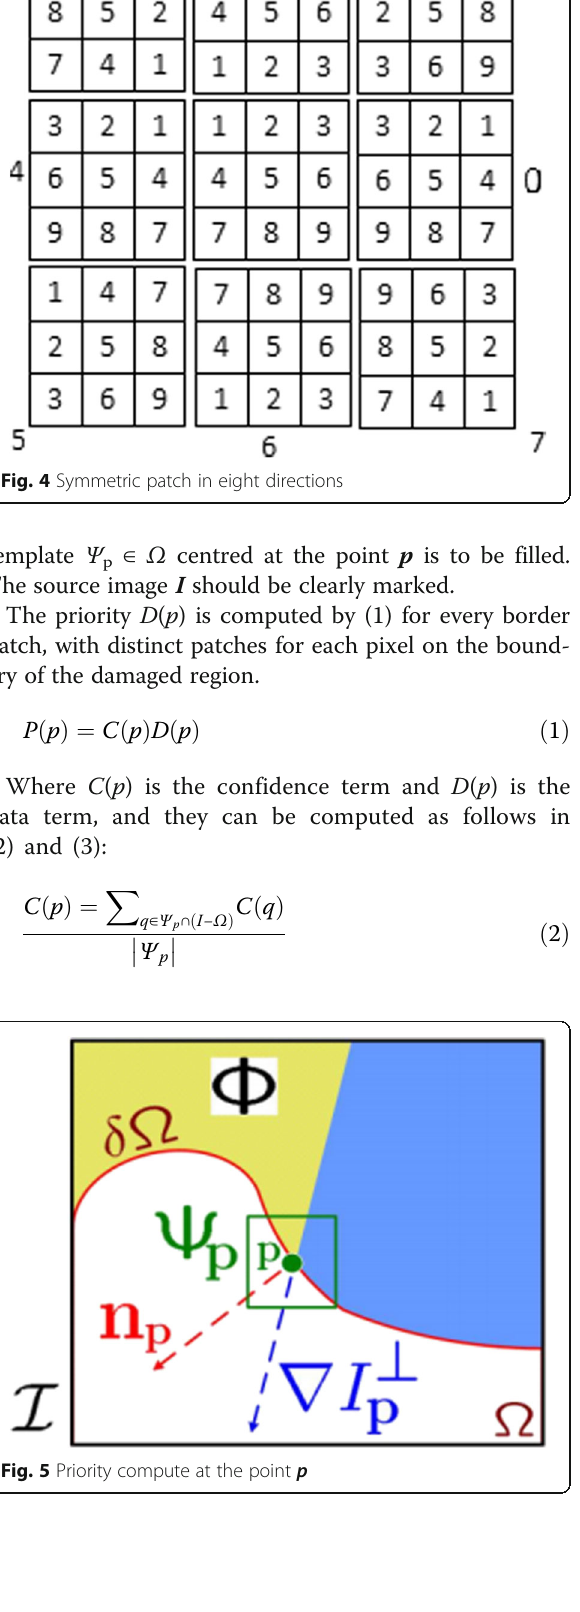
Fig. 5 Priority compute at the point p